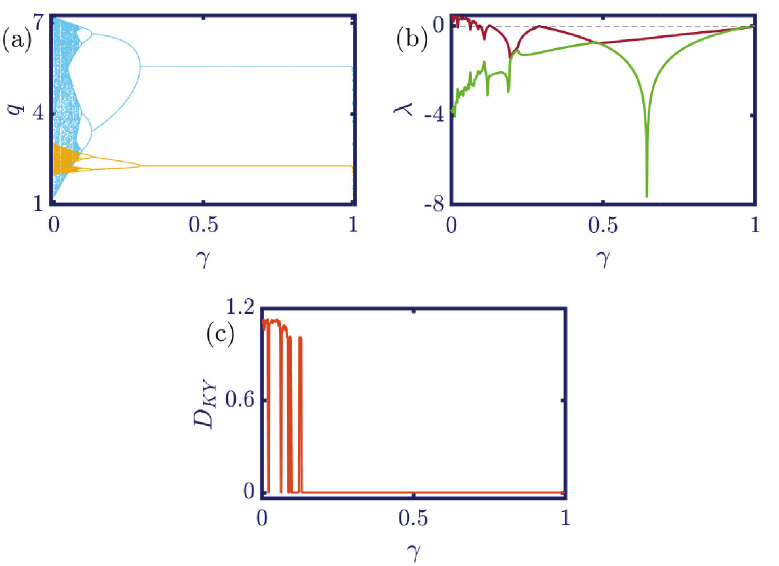
Fig 12. Eq (27) dynamics concerning the control parameter γ with a = 6, b = 0.5, c 1 = 2, c 2 = 1, d 1 = 0.5, d 2 = 1, v 1 = 0.1, v 2 = 1 and initial conditions q 1 (0) = q 2 (0) = 1. (a) Bifurcation diagram, (b) Lyapunov exponents spectra, and (c) Kaplan-Yorke dimension. With the increase in the value of γ the behavior of the controlled system changes from chaotic to periodic gradually and finally to a fixed point. The inverse period doubling is seen and after the critical point γ c = 0.3 the control parameter is large enough to force the model to converge to its stable Nash equilibrium. In the sub- figure (a), the cyan points represent the data for the leader firm ( q 1 ), whereas, the yellow points represent those for the follower firm ( q 2 ), and in sub-figure (b), the red and green points present the Lyapunov exponent spectra for the leader and follower firms respectively, namely λ 1 and λ 2 . https://doi.org/10.1371/journal.pone.0283757.g012 PLOS ONE | https://doi.org/10.1371/journal.pone.0283757 April 5,